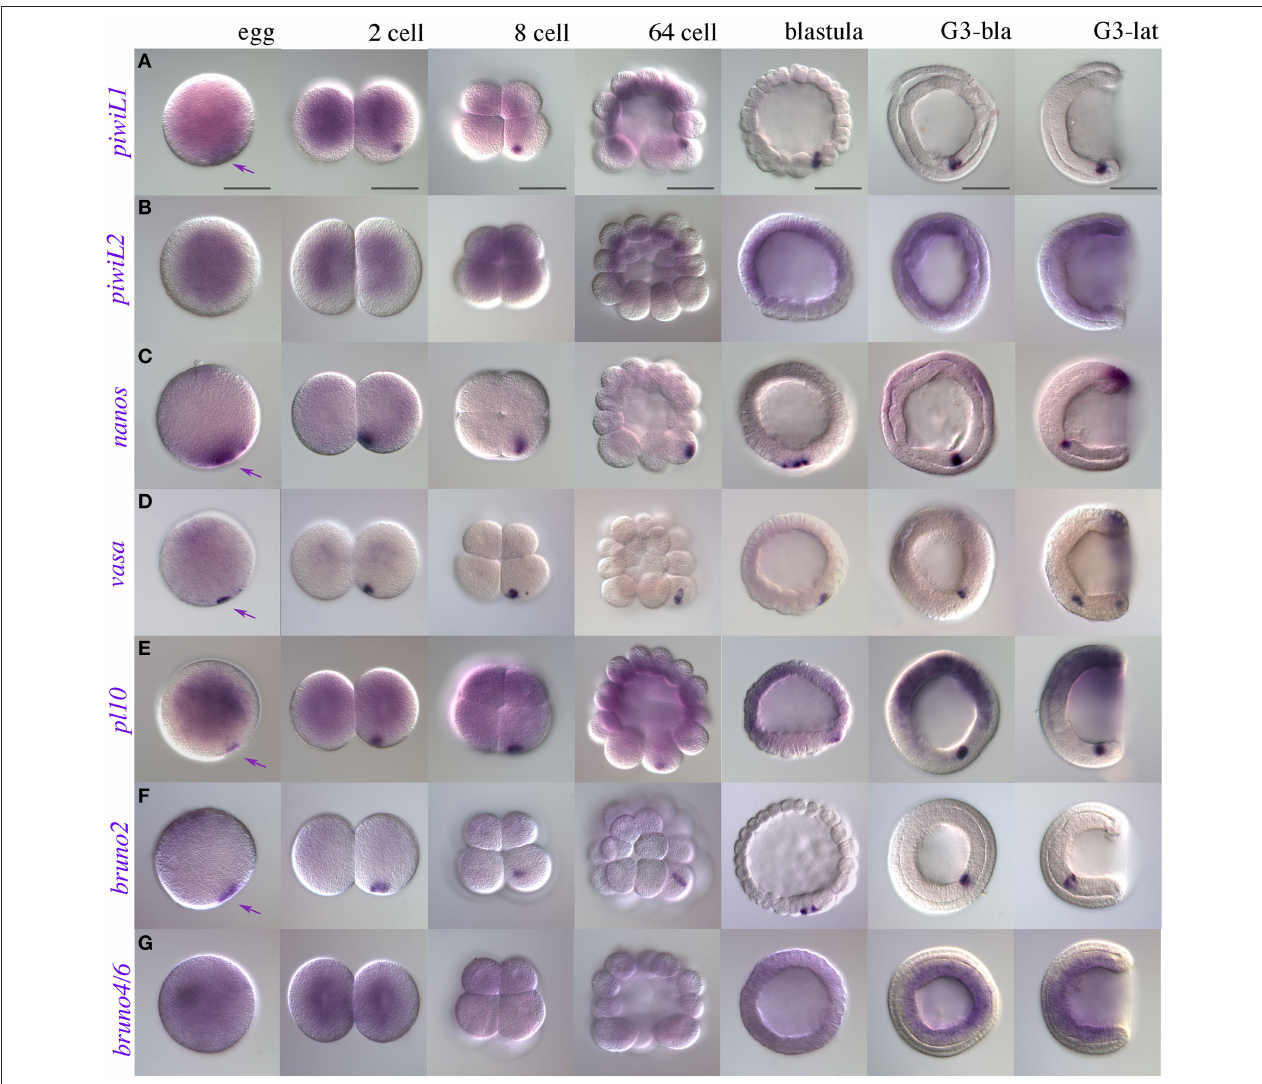
FIGURE 3 | Early expression of putative somatic stem cell and germline markers in B. lanceolatum . (A) piwi-like1; (B) piwi-like2; (C) nanos; (D) vasa; (E) pl10 ; (F) bruno2 ; (G) bruno4/6 . Purple arrowheads indicate putative PGC-associated expression, as early as the fertilized egg, of piwi-like1 , nanos , vasa , pl10 , and bruno2 . Stages are indicated along the top of the figure in panel (A) , from egg to mid-gastrula stages (G3). In morula (ca 64-cell) and blastula stages, macromeres are oriented downwards. G3-bla, blastopore view; G3-lat, lateral view. Scale bars = 50